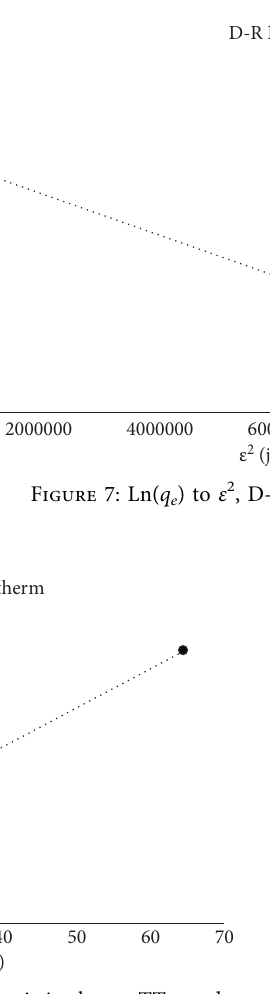
Figure 9: Ln( q e )variations toLn( C e ),Freundlich isotherm,